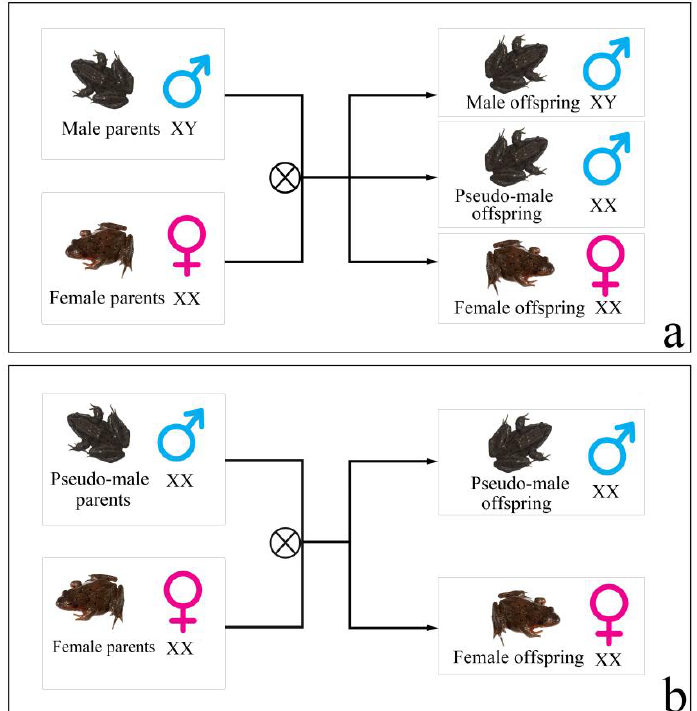
Figure 1. The offspring of male and pseudo-male R. dybowskii parents. ( a ) The offspring of male. ( b ) The offspring of pseudo-male.